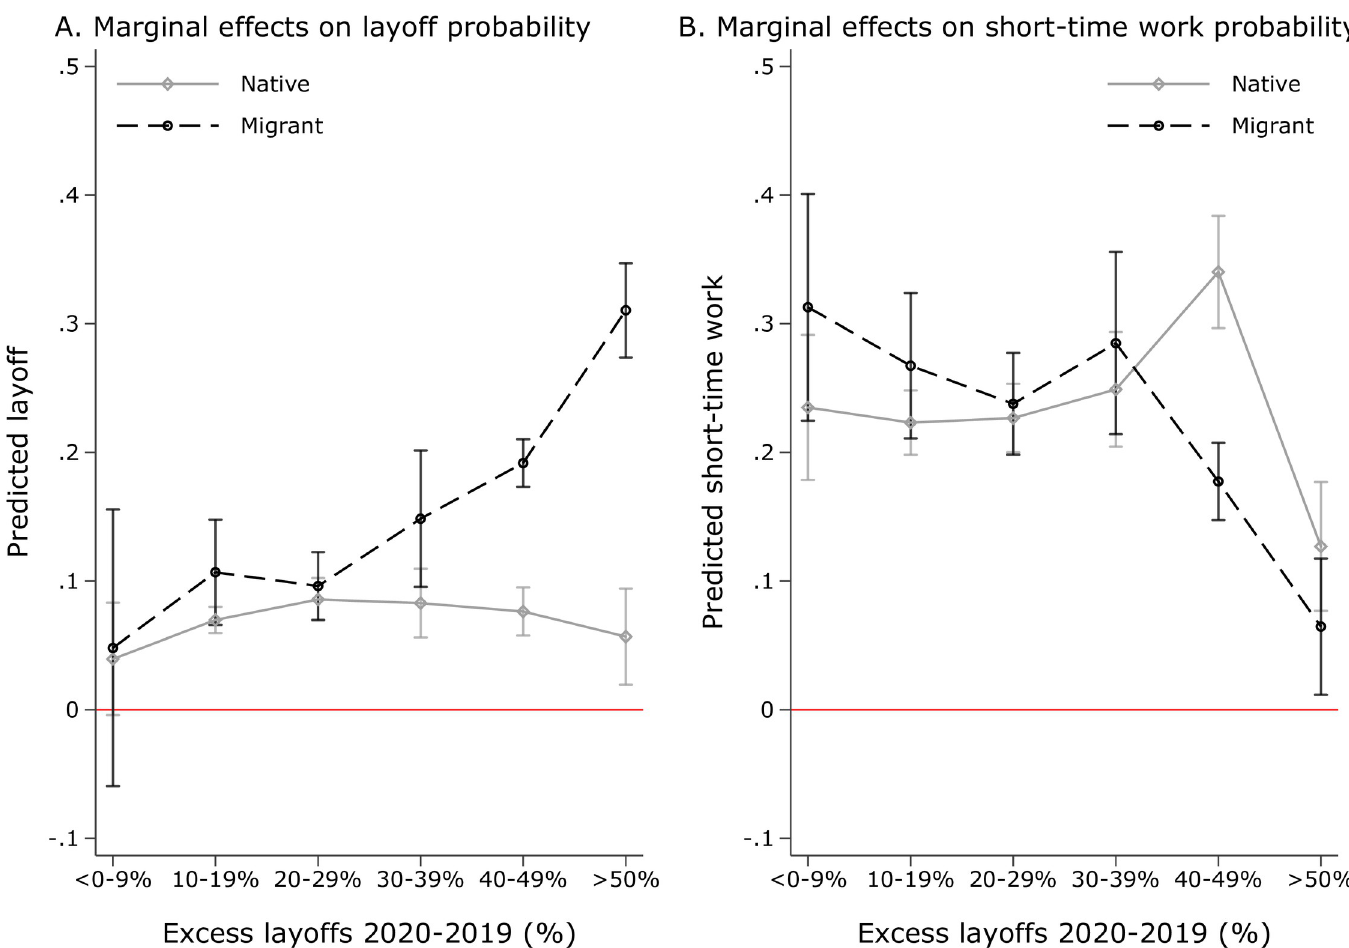
Fig 4. Heterogeneous layoff patterns across crisis magnitudes. Note: Fig provides marginal effects of industry-specific crisis exposure on migrants’ and natives’ layoff/ short-time work probability in Panels A and B, respectively. The corresponding regression is presented in S5 Table. Source: Federal Employment Agency (2021), own